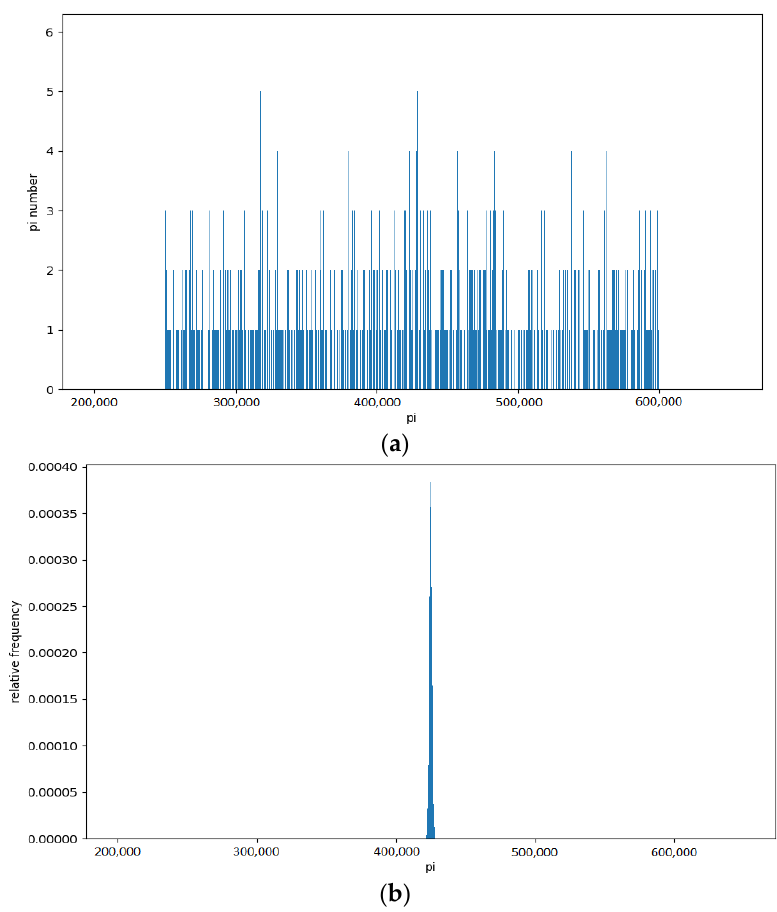
Figure 12. Mean distribution estimation through interval distribution: ( a ) interval distribution of all pixel values; ( b ) mean distribution through sampling average (100,000 samples performed 100,000 times).